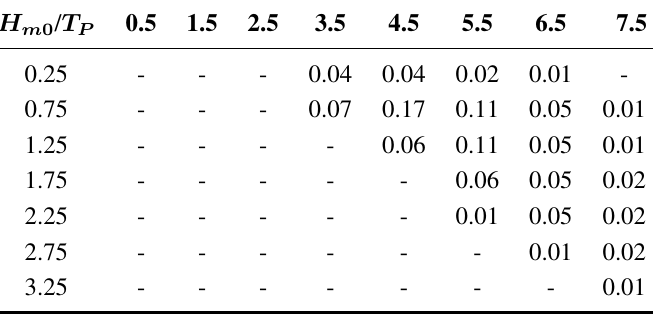
Table 1. Relative occurrence of different wave states from six years, buoy measurements ([ H ] = m, [ T ] = s). Both parameters defines the mean value over an interval. The adopted m 0 P discretisation is 1 s in T and 0.5 m in H p m 0